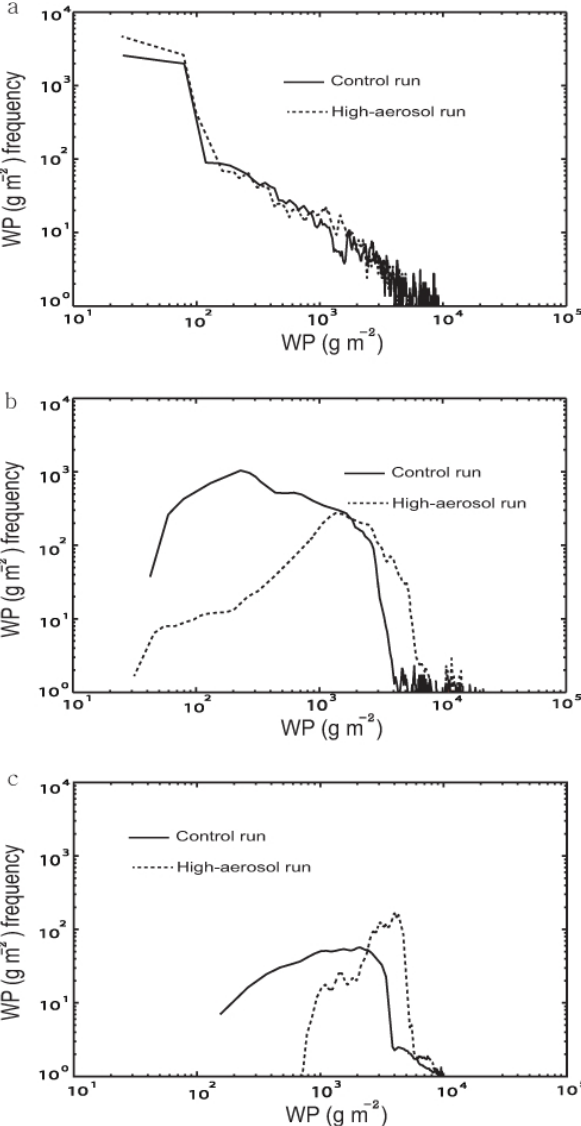
Fig. 10. Frequency distribution of WP over a period (a) between 12:00LST on 23 January and 00:00LST on 24 January, (b) between 00:00LST on 24 January and 18:00LST on 24 January, and (c) be- tween 18:00LST on 24 January and 12:00LST on 25 January.